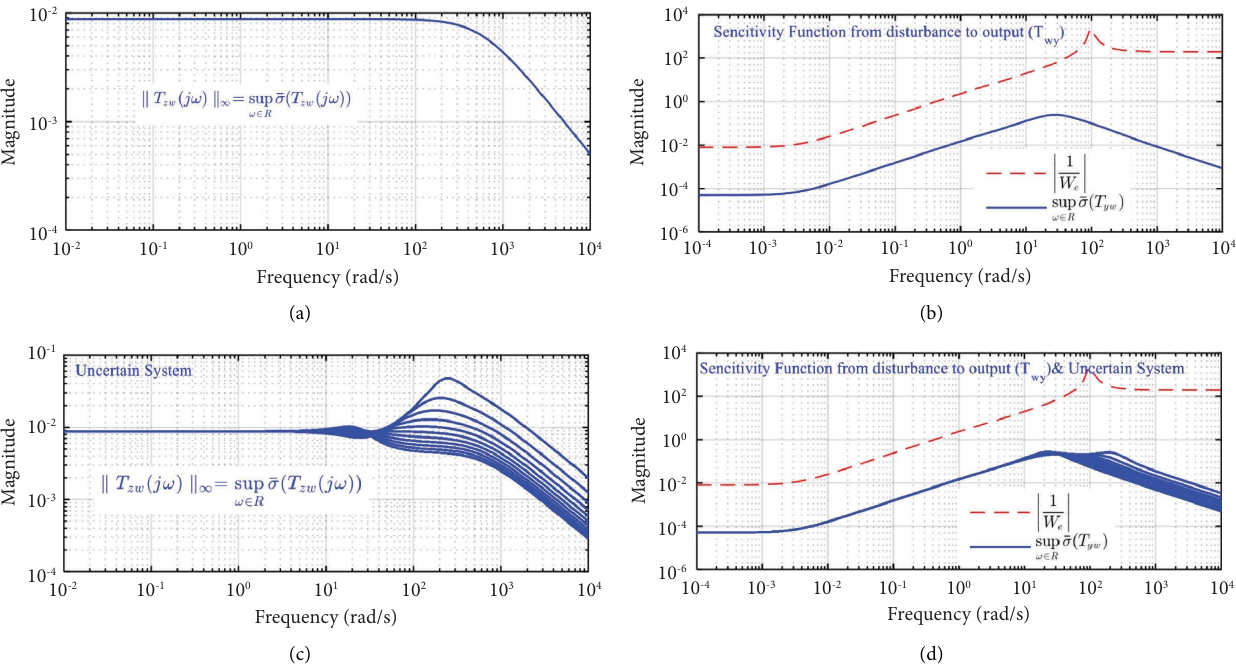
Figure 8: (a) NP index for the augmented system, (b) sensitivity function from disturbance to T performance of the uncertain augmented system, and (d) sensitivity function from disturbance to T